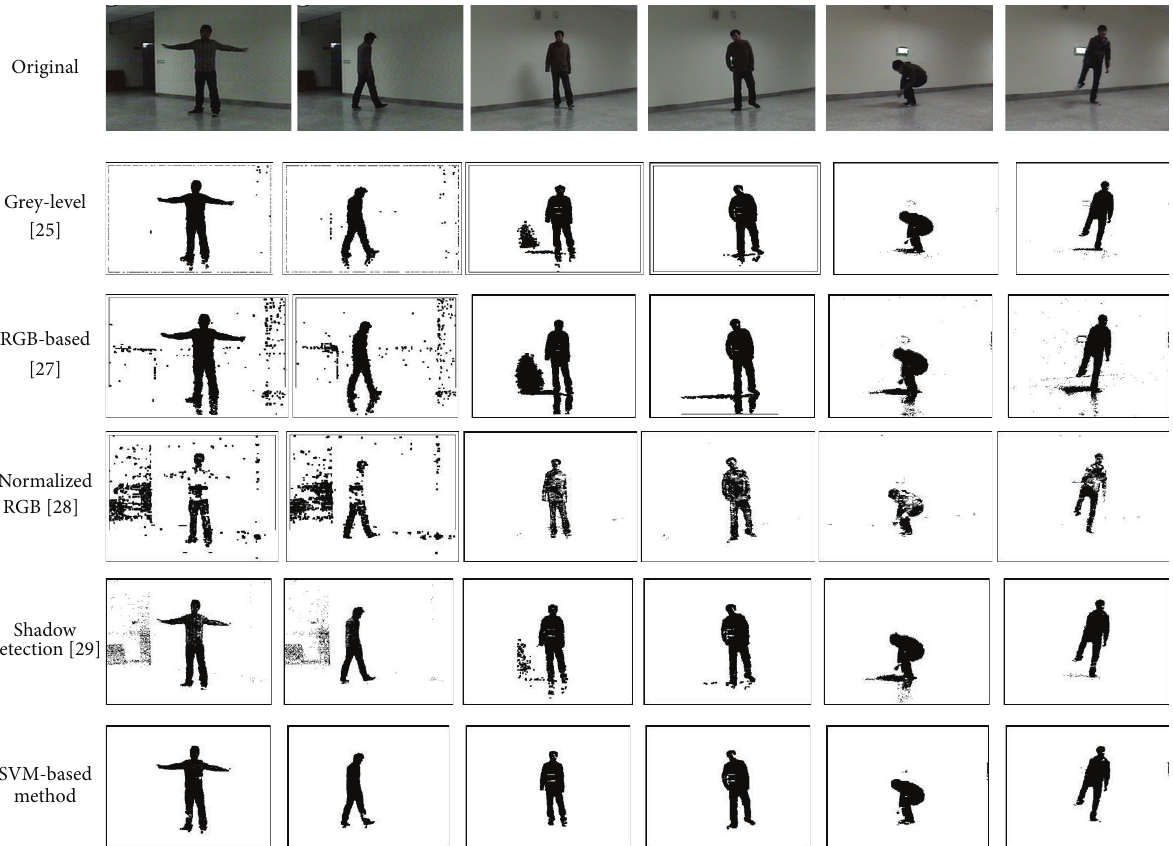
Figure 10: Human body segmentation results of different methods in Experiment